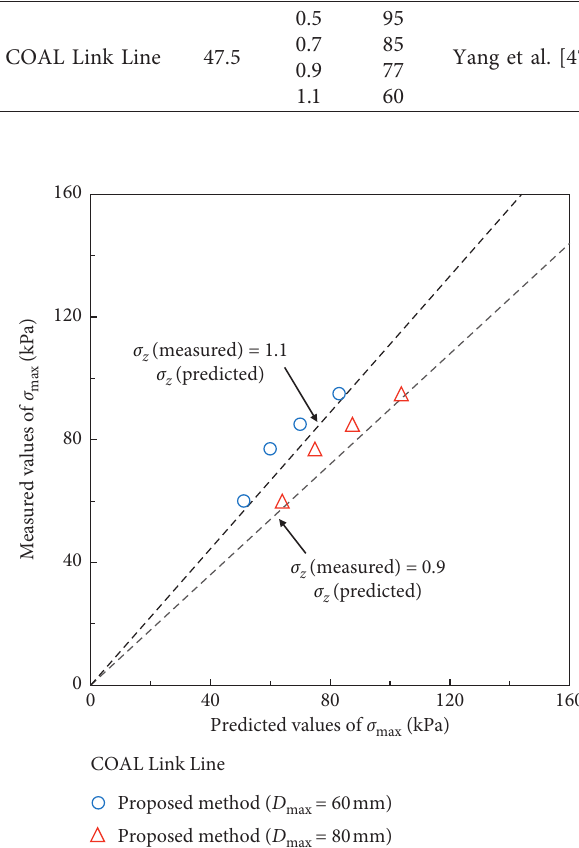
Figure 8: Comparisons between predicted results in the proposed method and measured vertical stresses for the case in South Africa.